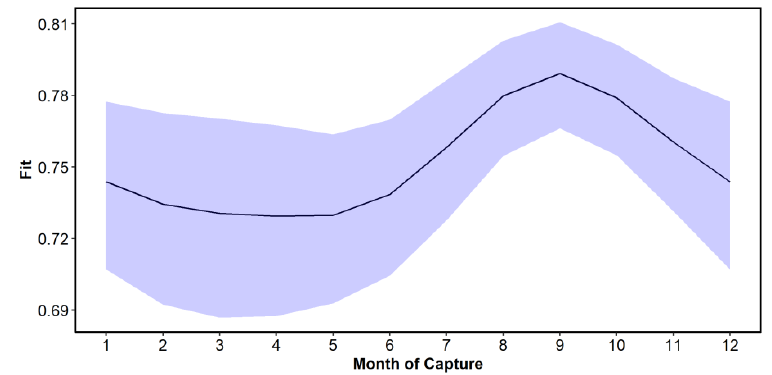
Figure 6 . Percent marginal edge type by month, ( a ), and by month and age group (number of annual bands binned), ( b ). Months 3–4 for bin 1, month 2 for bin 2, and months 11–7 for bin 3 have a low number of samples (5 or less). Marginal edge type (O = opaque, WT = wide translucent, and NT = narrow translucent).